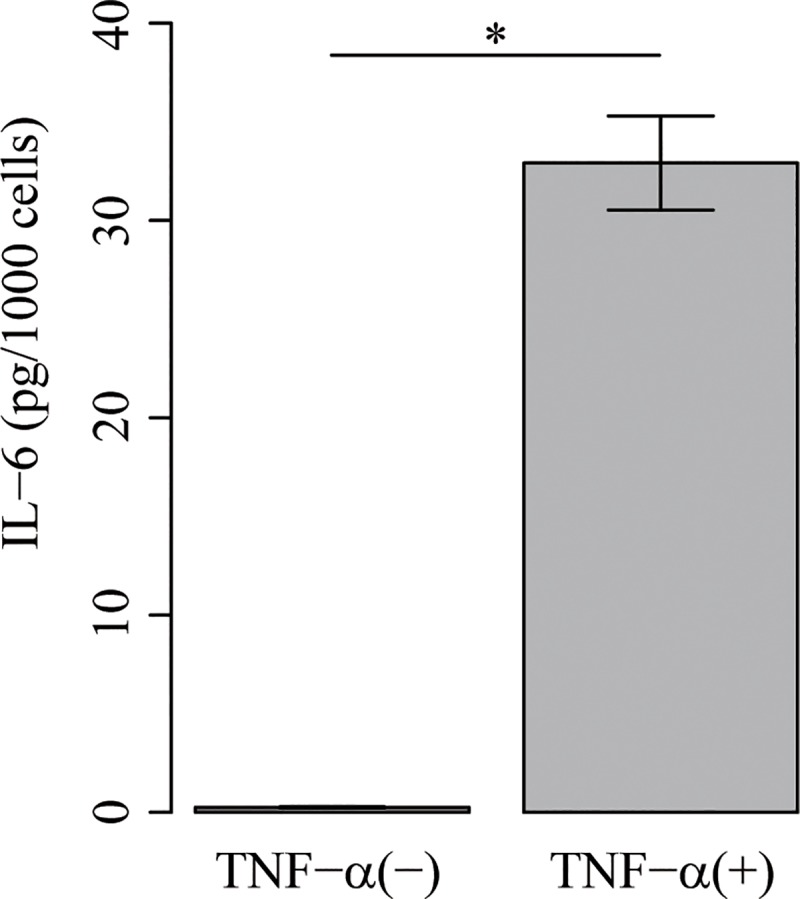
IL-6 secretion with or without TNF-α stimulation.Values are given as mean ± standard error (n = 3). *Statistical significance was determined by Welch’s t-test (P < 0.01).